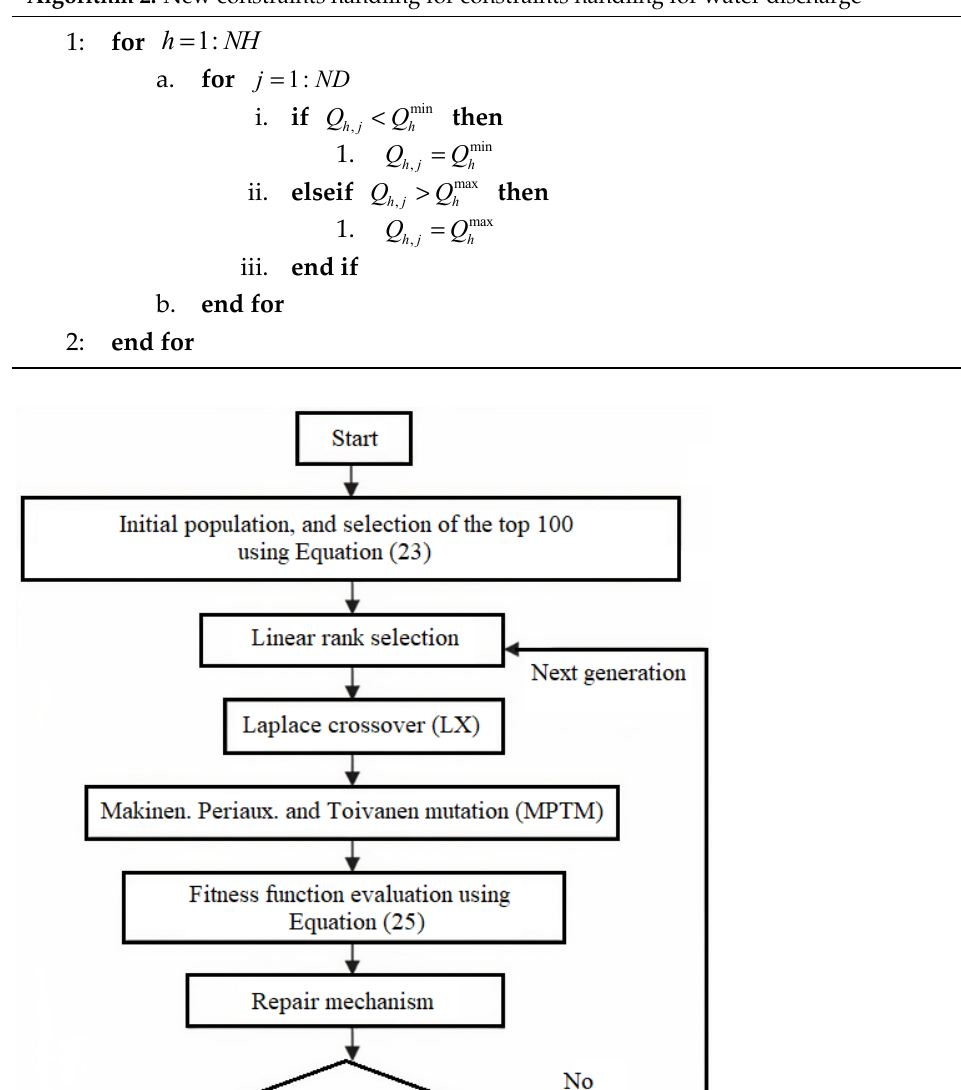
Algorithm 2: New constraints handling for water discharge